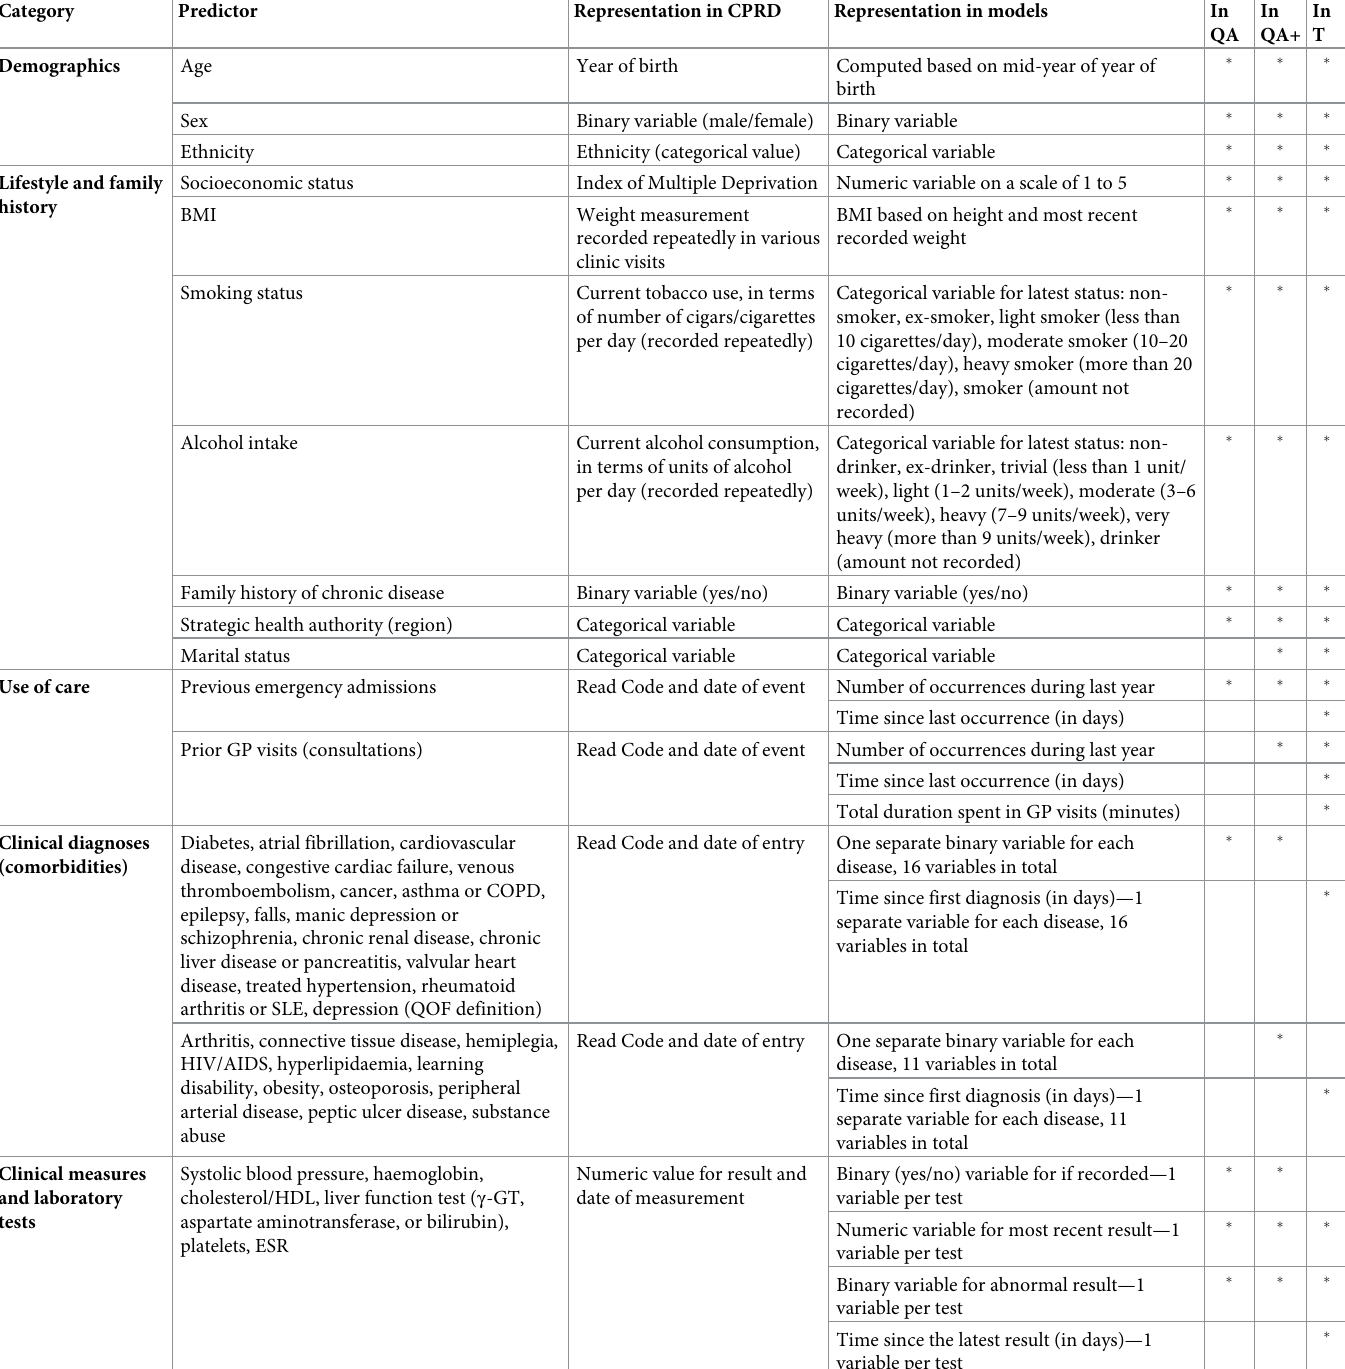
Table 1. Predictors considered, and how they are represented in CPRD and in our